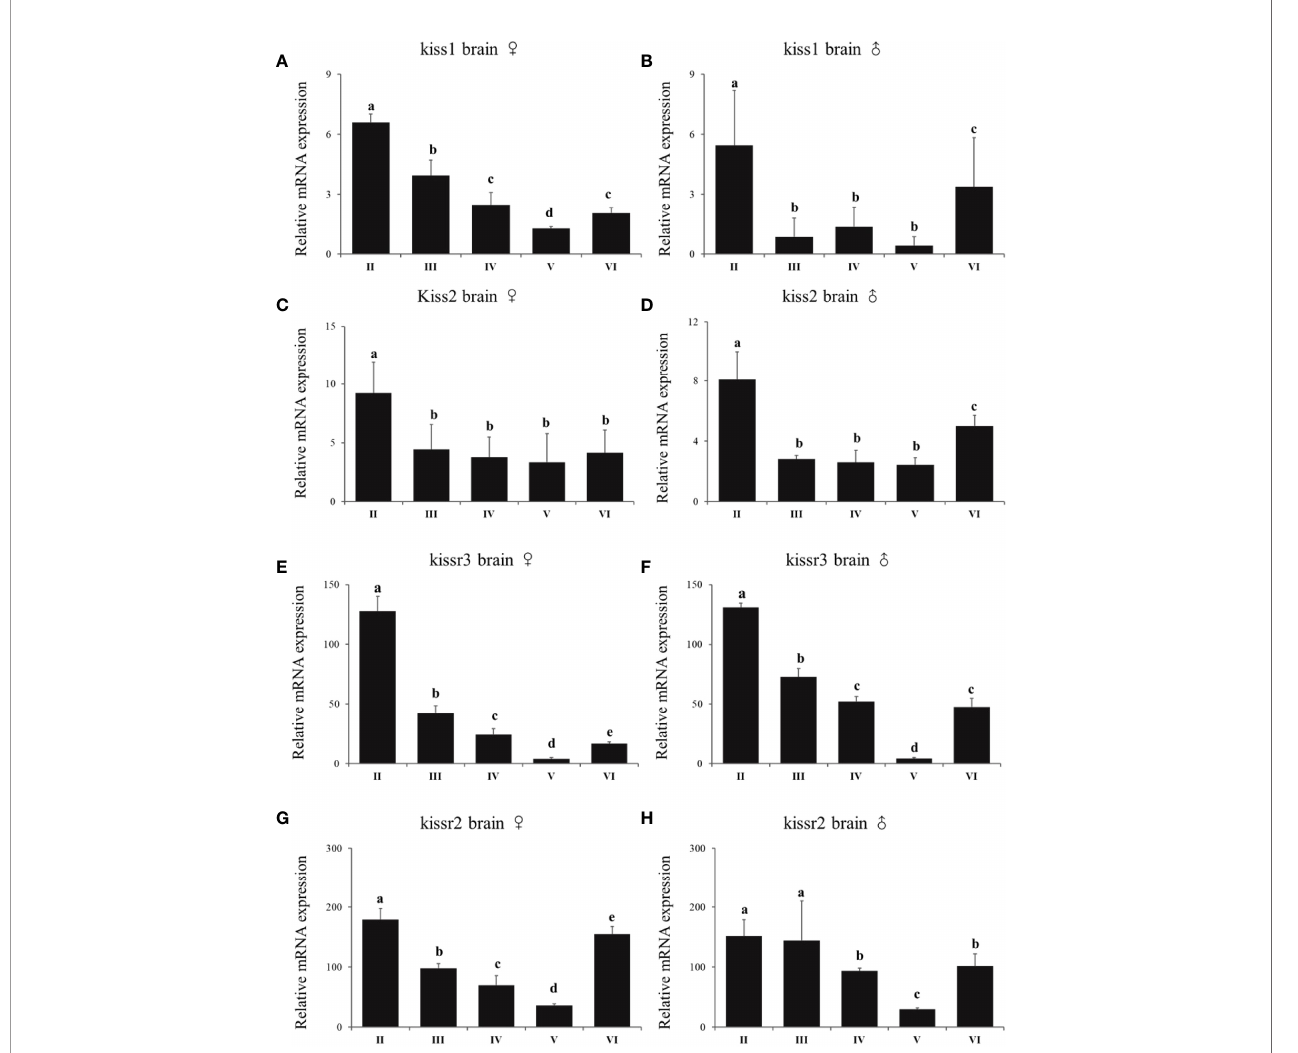
FIGURE 7 | Expression pro fi les of kiss/kissr genes throughout the reproductive cycle in the brains of female (A, C, E, G) and male (B, D, F, H) . Error bars are presented as the mean±SEM. Different letters above bars represent statistical signi fi cance (p < 0.05) between two reproductive